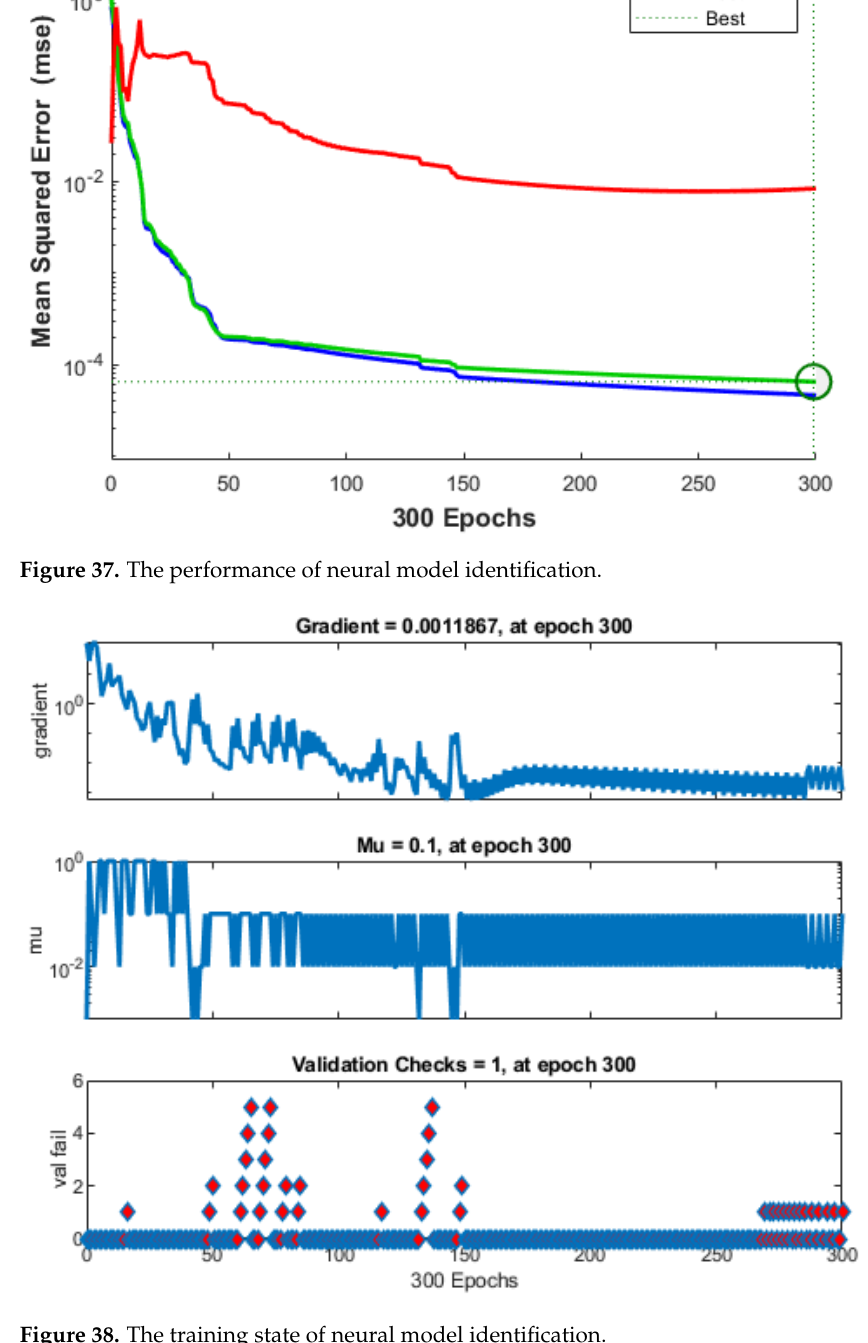
Figure 38. The training state of neural model identification.